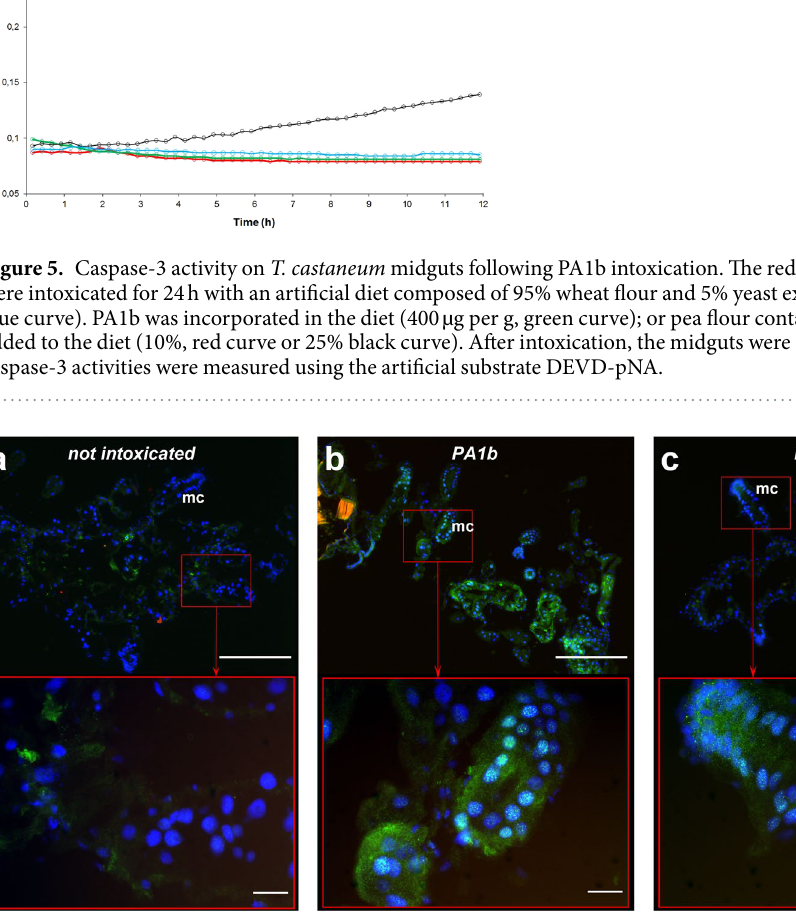
not detected in the midguts. When PA1b was added to the medium, caspase-3 was detected at a very low level in the midgut of T. castaneum (Fig. 7d), but not in resistant weevils (Fig. 7b). V-ATPase (receptor of PA1b) and caspase-3 are close-localized. Due to technical constraints, the immuno-localization of caspase-3 and of V-ATPase was performed on three successive sections of gut from the S. oryzae strain WAA42, separated by 7 µ m. In the first photograph (Fig. 8a), non-immune serum was applied to the slides as a negative control. Therefore, only the nuclei were stained blue and it was possible to identify the mesenteric caeca in the weevil gut. In the second section of the same gut structure (Fig. 8b), the V-ATPase was red and was localized on the caeca membrane; in the third section (Fig. 8c) the caspase-3 active form was green and was clearly localized on the same membrane as caspase-3. PA1b insect resistance induces bafilomycin resistance. S. oryzae PA1b sensitive (WAA42) and resist- ant (ISOR3) strains, and the insensitive insect T. castaneum , were reared on non-treated medium (Fig. 9a,b and c) or on medium containing bafilomycin (150 µ g per g of food) (Fig. 9d,e and f). After 4 days, the caspase-3 active form was detected, by immuno-localization, in midgut sections. Like PA1b, bafilomycin induced caspase-3